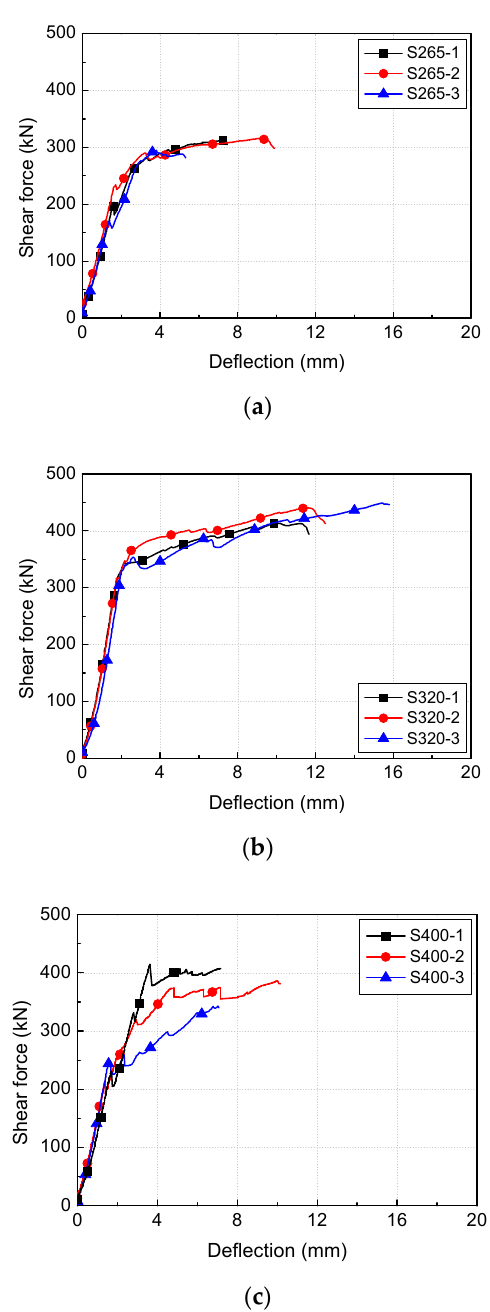
Figure 7. Shear force-deflection relationships of S series: ( a ) S265; ( b ) S320; ( c ) S400.